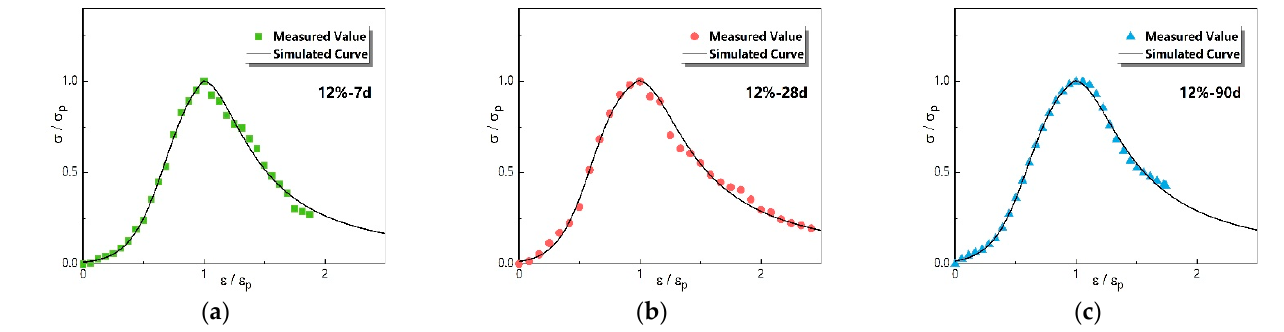
Figure 7. The verification results of the constitutive model. ( a ) verification results of NSS after a 7-day curing period; ( b ) verification results of NSS after a 28-day curing period; ( c ) verification results of NSS after a 90-day curing period.